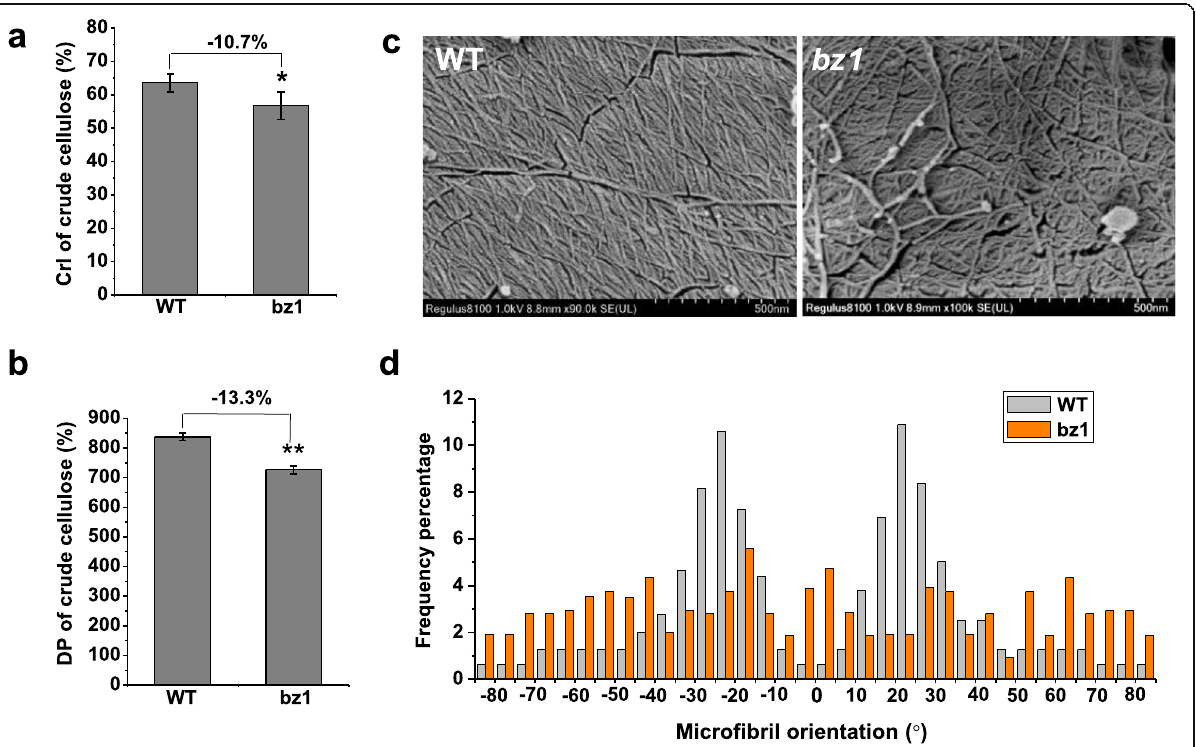
Fig. 4 Detection of cellulose structural features. a Lignocellulose CrI of mature stems using the X-ray diffraction (XRD) method. b Cellulose DP of mature stems using the viscometry method. c Cryogenic scanning electron microscopy (Cryo-SEM) views of cellulose macrofibrils/microfibrils of the stem at booting stage after treatment with Updegraff reagent. d Distribution of macrofibrils/microfibrils orientation. The orientation of macrofibril/microfibril is represented as percentage frequency of the orientation of macrofibril/microfibril segments identified using the software Gwyddion ( n = 3000 snakes from three images of three cells of three individual